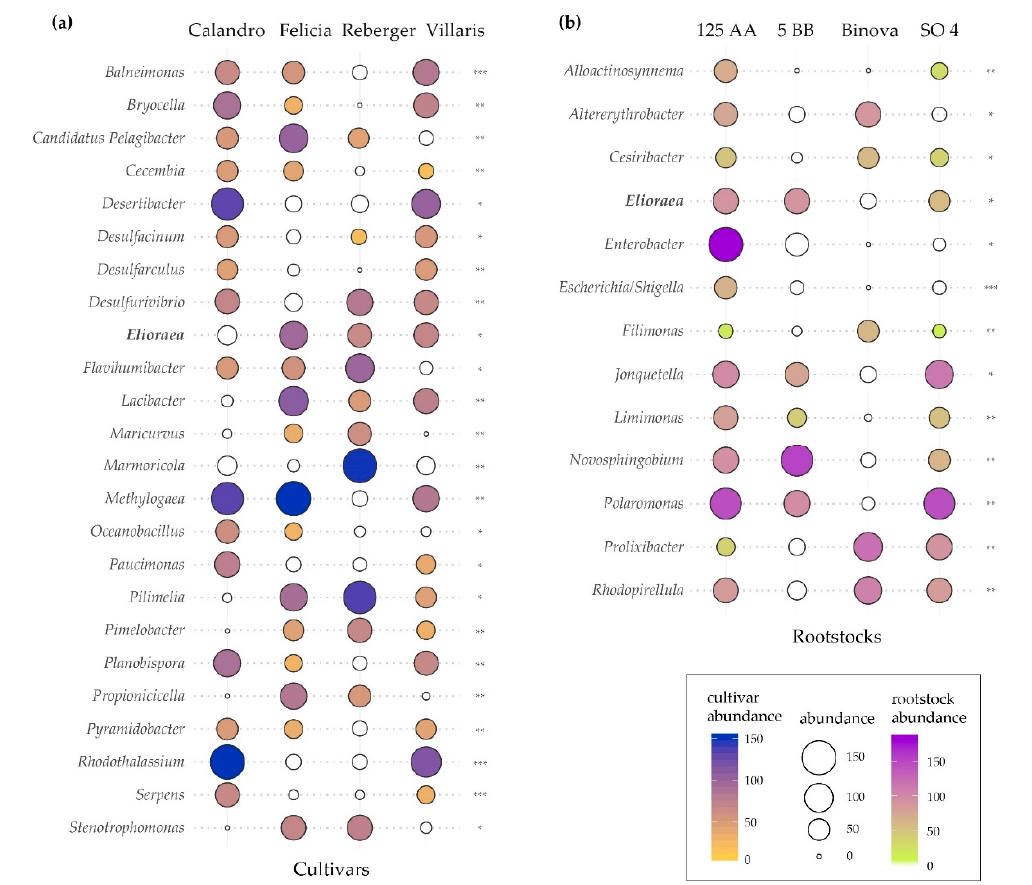
Figure 4. Indicator species analysis of bacterial genera per cultivars ( a ) or rootstocks ( b ). Color and bubble size relate